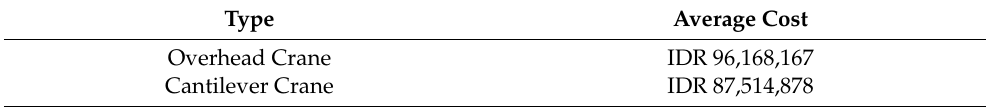
Table 9. Average Capital Cost for Overhead and Cantilever Crane.